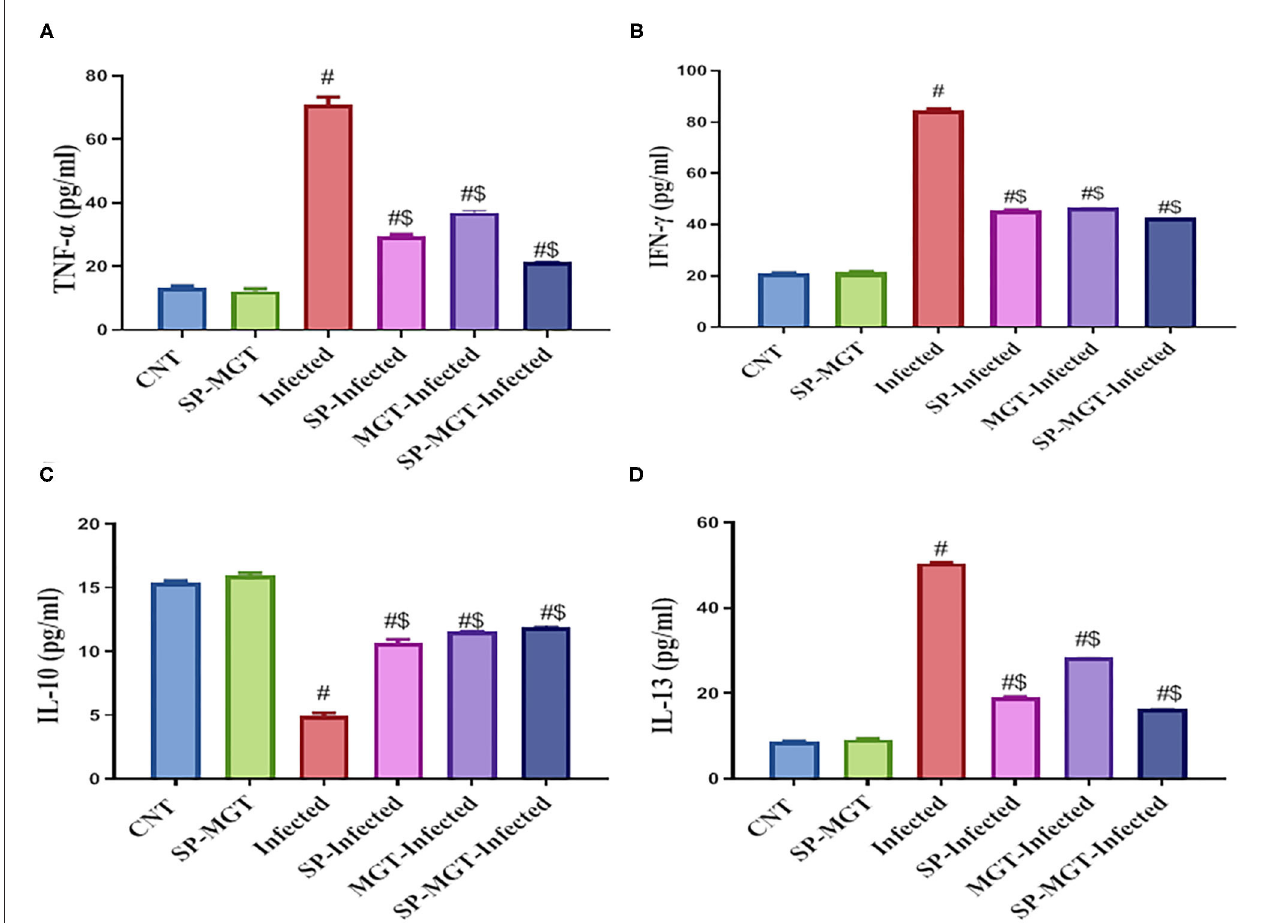
FIGURE 4 | Tumor necrosis factor-alpha (TNF- α ; A ), interferon-gamma (IFN- γ ; B ) levels, interleukin 10 (IL-10; C ), and interleukin-13 (IL-13; D ) in serum of mice in response to co-treatment with Spirulina platensis and/or matcha green tea in S. mansoni infected mice. Data were displayed as mean ± SEM ( n = 10/group). # or $ refers to the statistical significance at P < 0.05 against control and S. mansoni (infected) groups,